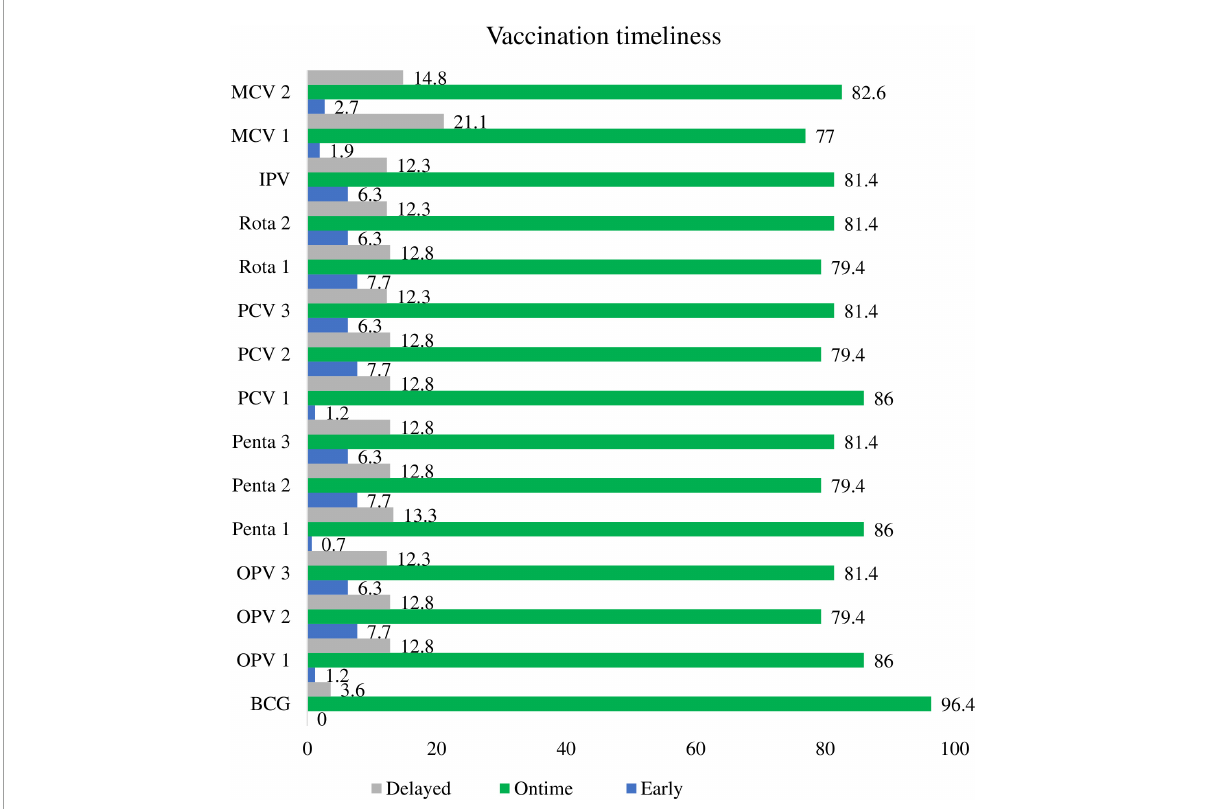
FIGURE4 Vaccination timeliness for specific antigen among children aged 12-23 months.